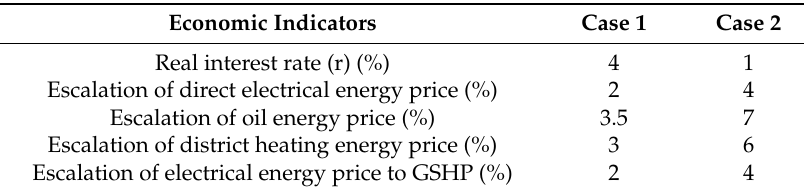
Figure 5. The change in energy price of electrical, light oil, district heating and direct electrical heating for detached house consumers [62]. Prices include excise tax as well as a precautionary stock fee. All told, the discounted payback time is highly affected by the economic assumptions (real interest rate and energy price escalation rate). The literature shows that, during the last years, the energy price escalations of district heating and light oil are higher than the escalation of electricity price. The average value of the real interest rate (r) during the last ten years, in Finland, is around 1%. Hence, in the current study, two economic cases are investigated. The first case assumes high real interest rate (4%) and low energy price escalations 2%, 3.5%, 3%, and 2% for the four studied heating energy sources, i.e., direct electrical heating, oil fire boiler, district heating, and GSHP, respectively. The second case addresses lower real interest rate and higher energy price escalations (see Table 1). Case 2 is closer to the current economic situation in Finland. Table 1. Assumptions of the two investigated